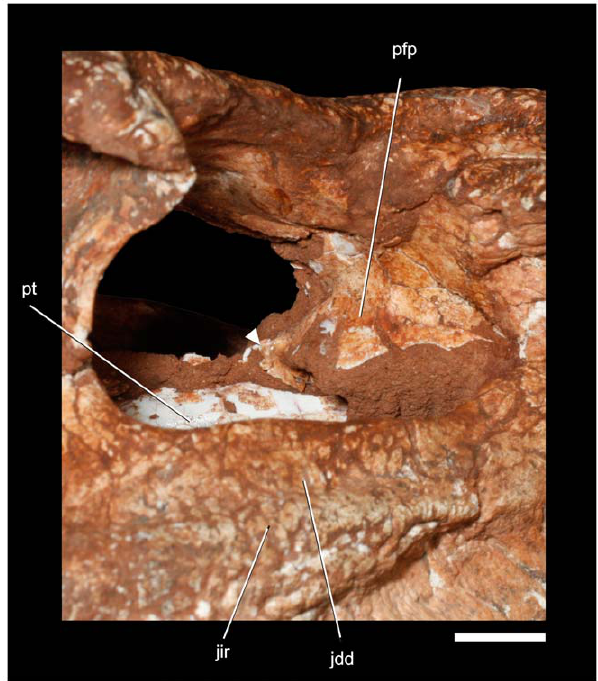
Figure 9. Details of the right prefrontal pillar of Pissarrachampsa sera (LPRP/USP 0019) through the orbit. Arrow points to the medioventral extension of prefrontal pillar. Abbreviations: jdd, jugal dorsal depression; pfp, prefrontal pillar. Scale bar equals 1 cm.